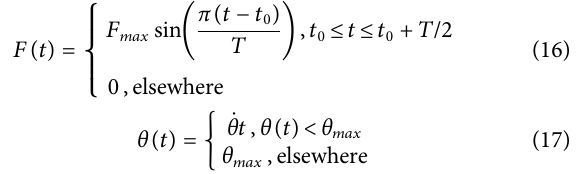
Frontiers in Built Environment |